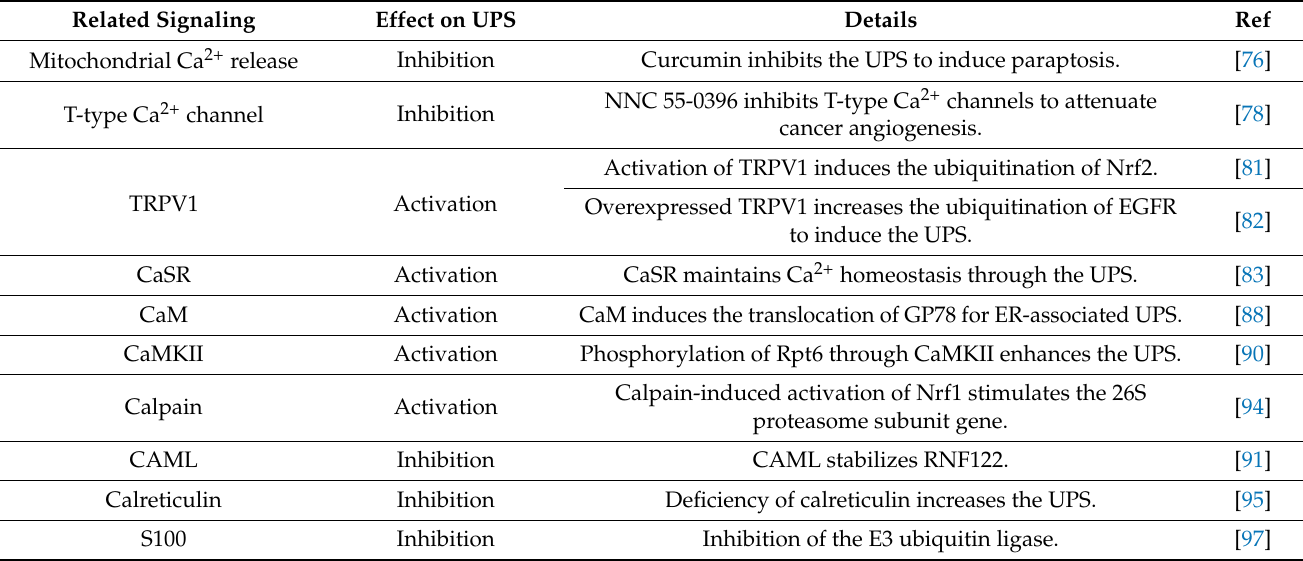
Table 1. The effect of Ca 2+ signaling on the